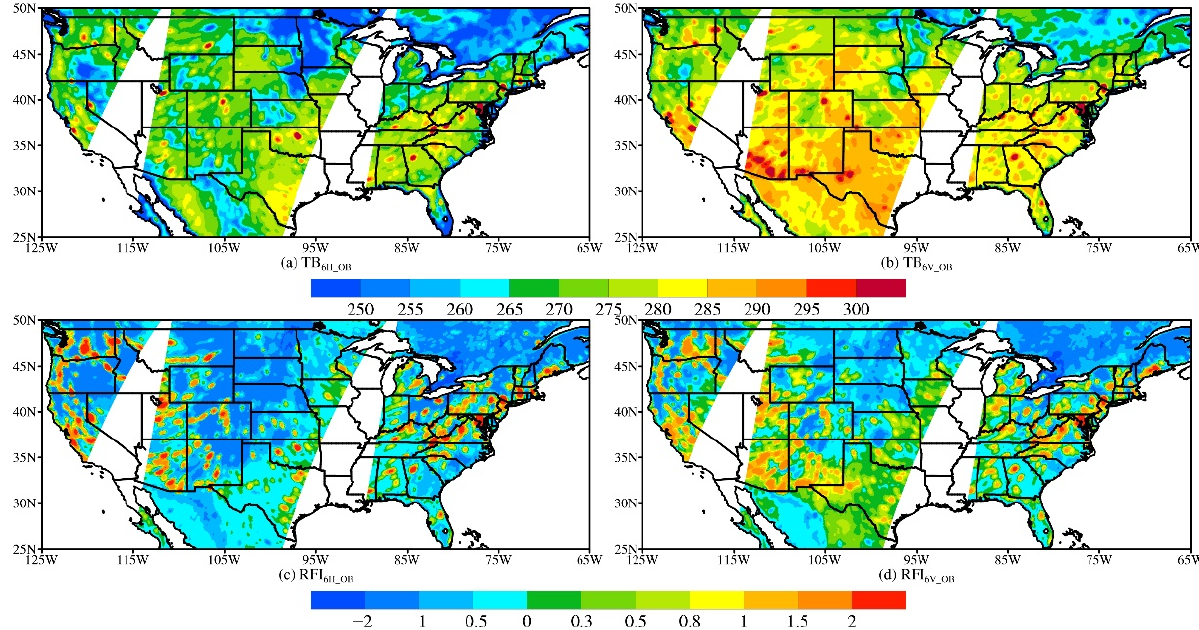
Figure 2. Spatial distribution of the brightness temperature ( a , b ) and RFI ( c , d ) under 6 GHz horizontal polarization ( a , c ) and vertical polarization ( b , d ) on 18 June 2016.